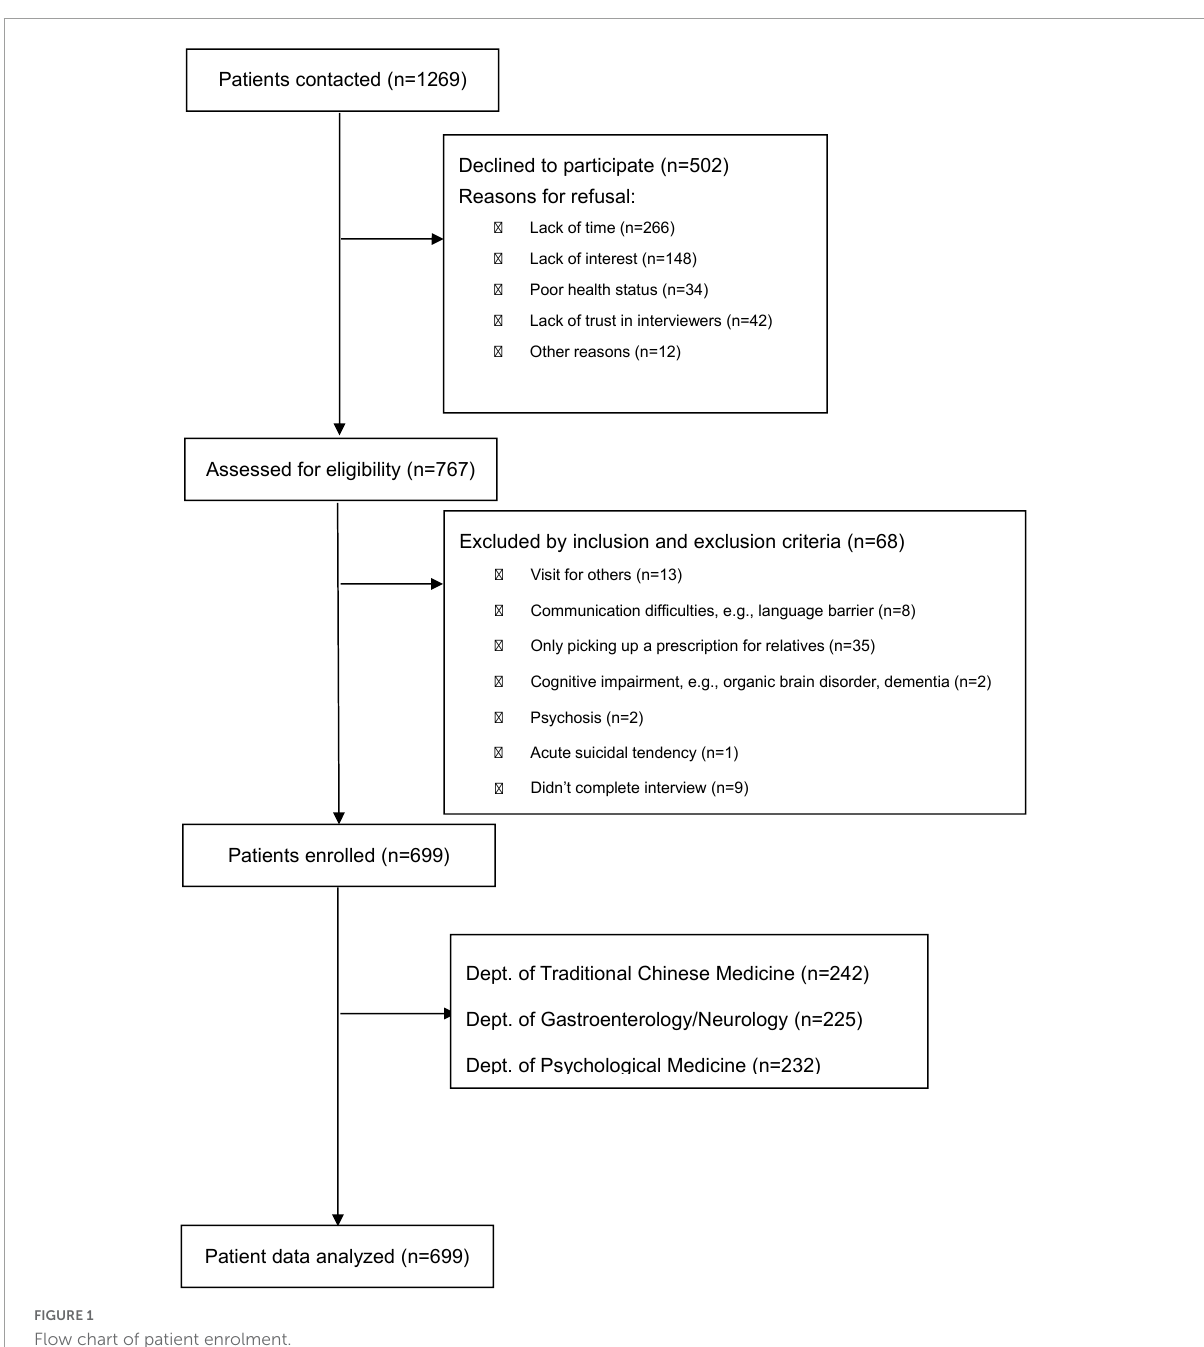
FIGURE1 Flow chart of patient enrolment.